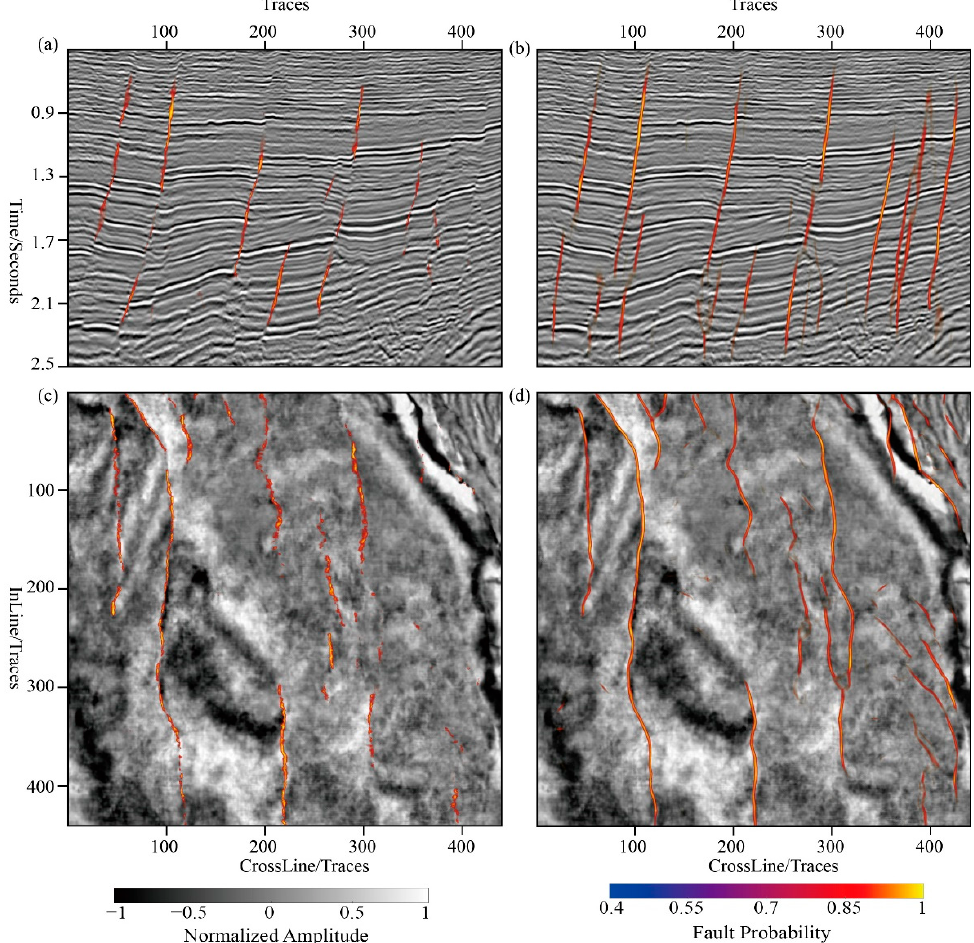
Figure 10. Comparison of the faults detection results on 2D slices by using the pre-trained U-Net model (left column) and the U-Net model after transfer learning (right column). Vertical slice and horizontal slice are inline 360 (( a ) and ( b )) and time = 1600 ms (( c ) and ( d )), respectively.